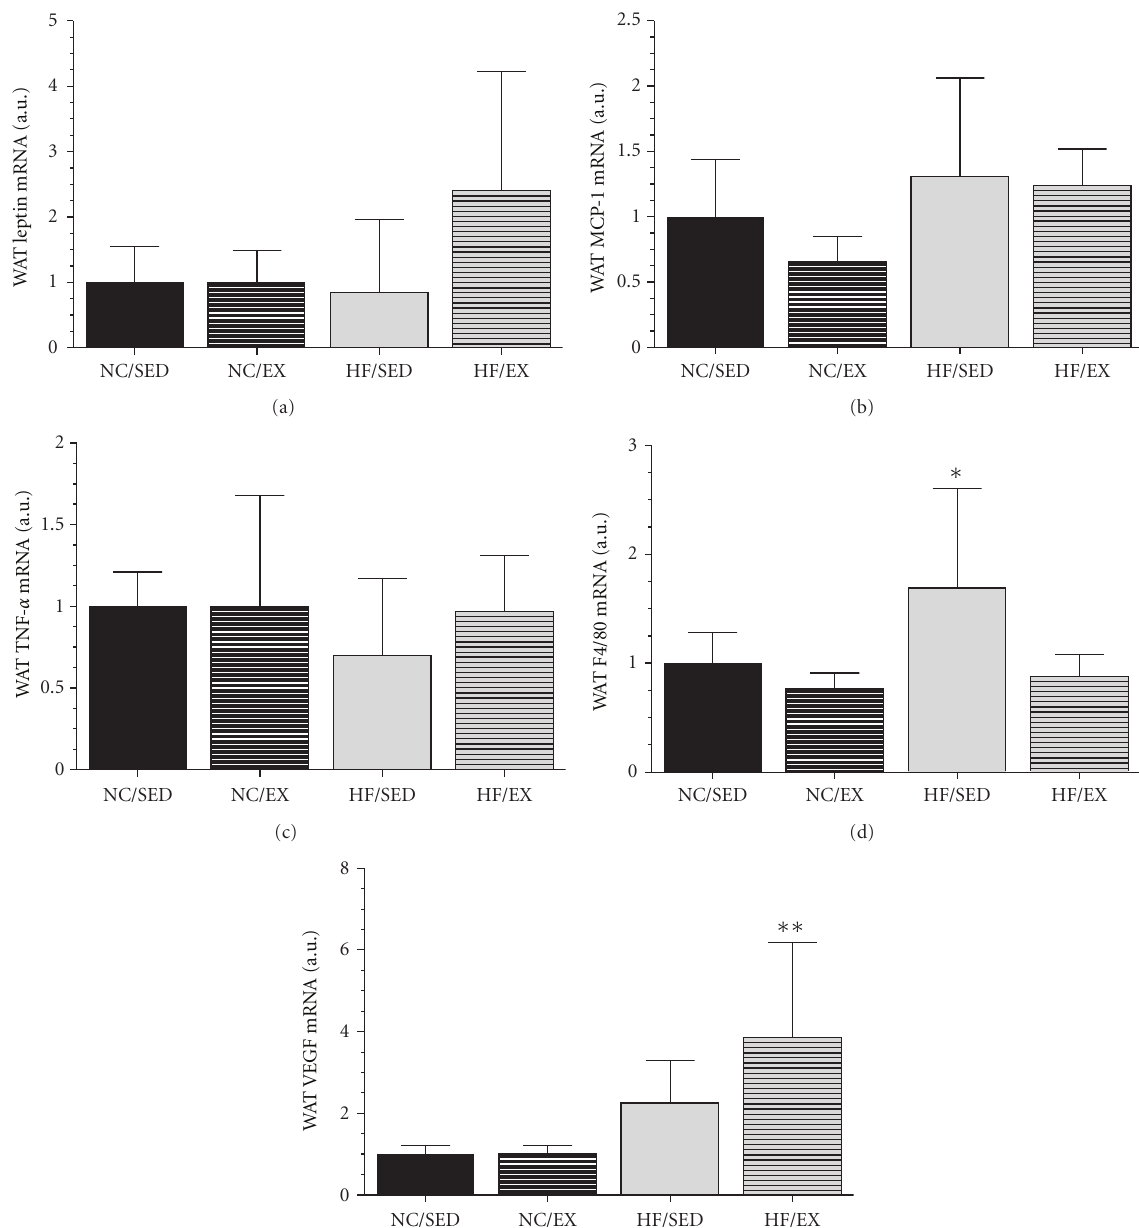
Figure 3: Leptin (a), monocyte chemoattractant protein-1 (MCP-1) (b), tumor necrosis- α (TNF- α ) (c), F4/80 (d), and vascular endothelial growth factor (VEGF) (e) gene expression represented as fold change over the normal chow/sedentary (NC/SED) group. ∗ High fat/sedentary (HF/SED) had greater F4/80 gene expression versus remaining 3 groups ( P < 0 . 05). ∗∗ HF/exercise (EX) expressed greater VEGF versus the other groups ( P < 0 . 05). Data normalized to GAPDH, with no di ff erences in GAPDH between groups. n =